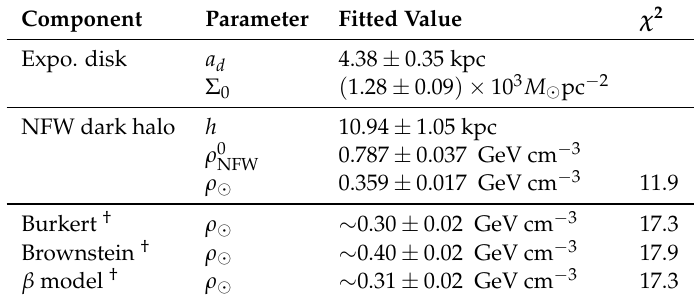
Table 3. Best-fit parameters of the direct SMD by NFW halo and exponential disk.